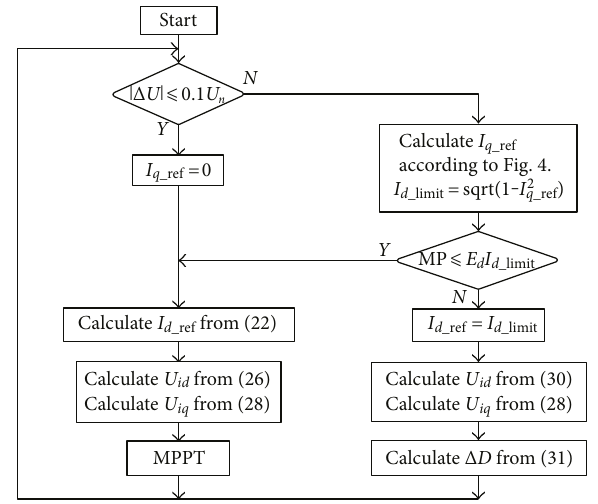
Figure 5: Synergetic control strategies of the PV